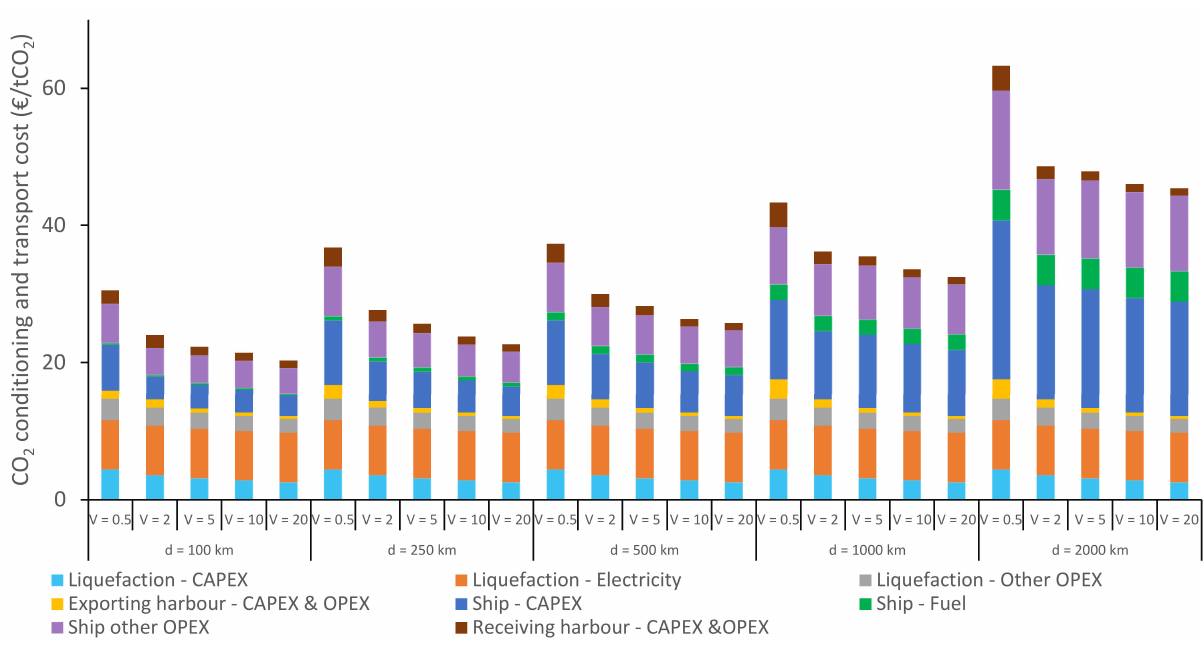
Figure A8. Cost breakdown of CO 2 conditioning and transport costs as a function of transport distance (d in km) and annual volume (V in MtCO 2 /year) when transporting pure CO 2 between two harbours by ship at 15 barg.